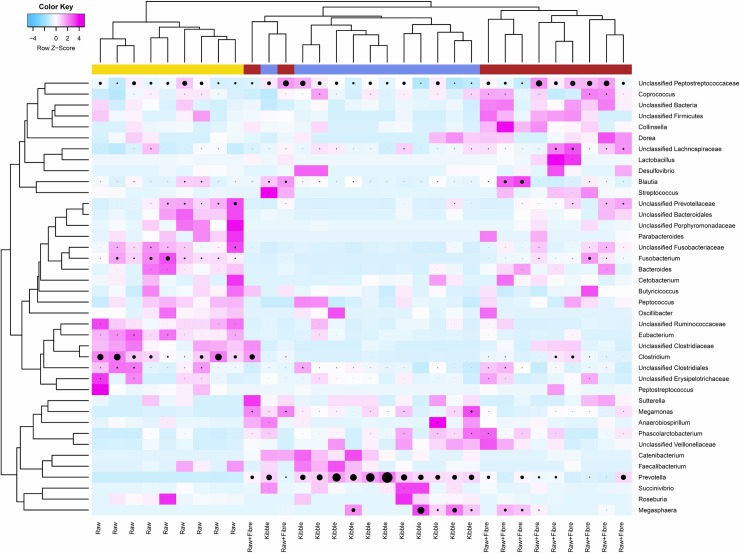
Heat map showing hierarchical clustering of bacterial relative abundances.Bacterial taxa are shown at the genus level from in the faecal bacteriome of adult domestic shorthair cats fed Kibble, Raw+Fibre and Raw diets. Heat map colours indicate normalized (Z score) relative abundance of each genus scaled across rows. Intensity of magenta colour denotes number of standard deviation above the mean and intensity of blue colour denotes number of standard deviation below the mean. Black circles show relative abundance of each taxa without scale normalization, with size of circle proportional to relative abundance. Colour ribbon at the top of the figure indicates diet; Raw (gold), Kibble (blue), and Raw+Fibre (red).